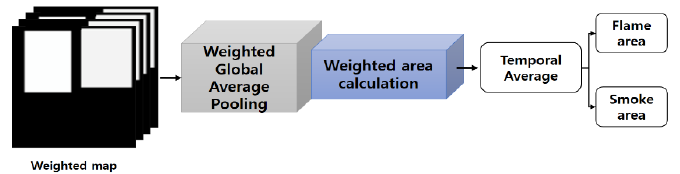
Figure 8. Calculation of weighted areas of SRoFs.